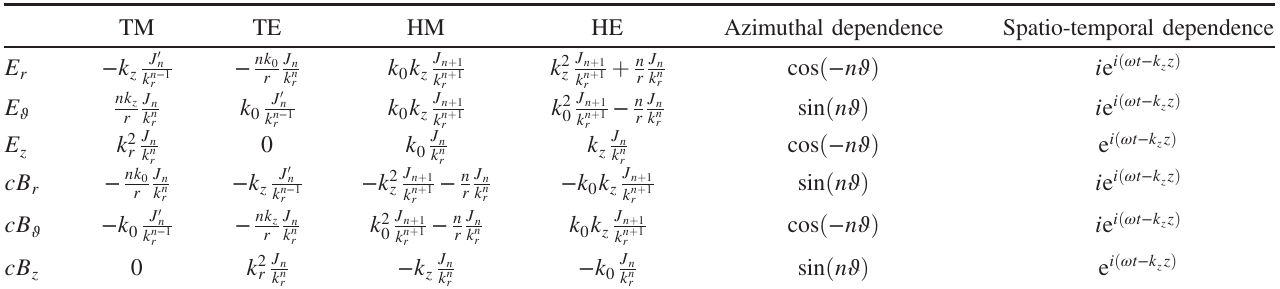
TABLE I. TM – TE and HM – HE basis